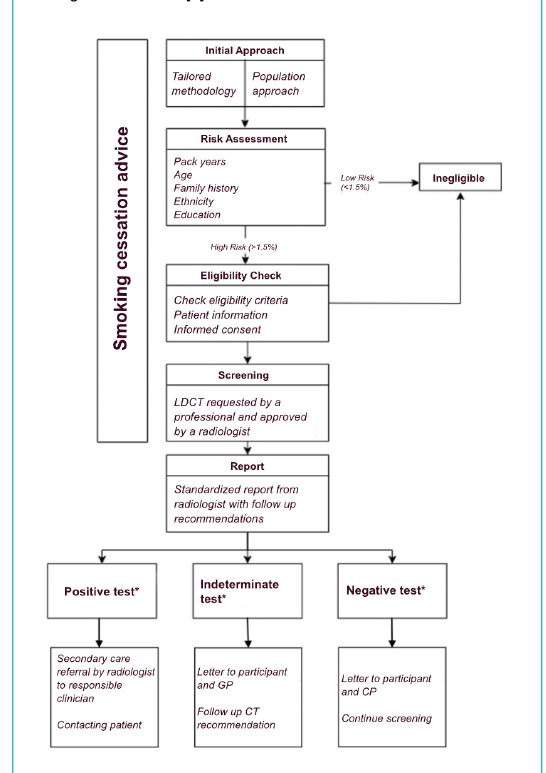
Figure 2: Participants pathway. *according to NELSON module management criteria [5]